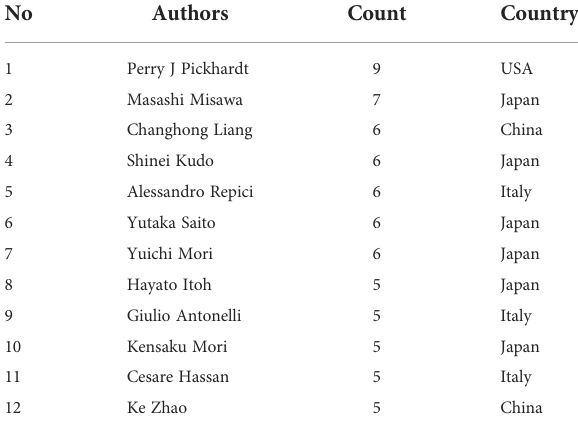
TABLE 3 Top 12 of most productive authors (Related studies reported ＞ 5) .